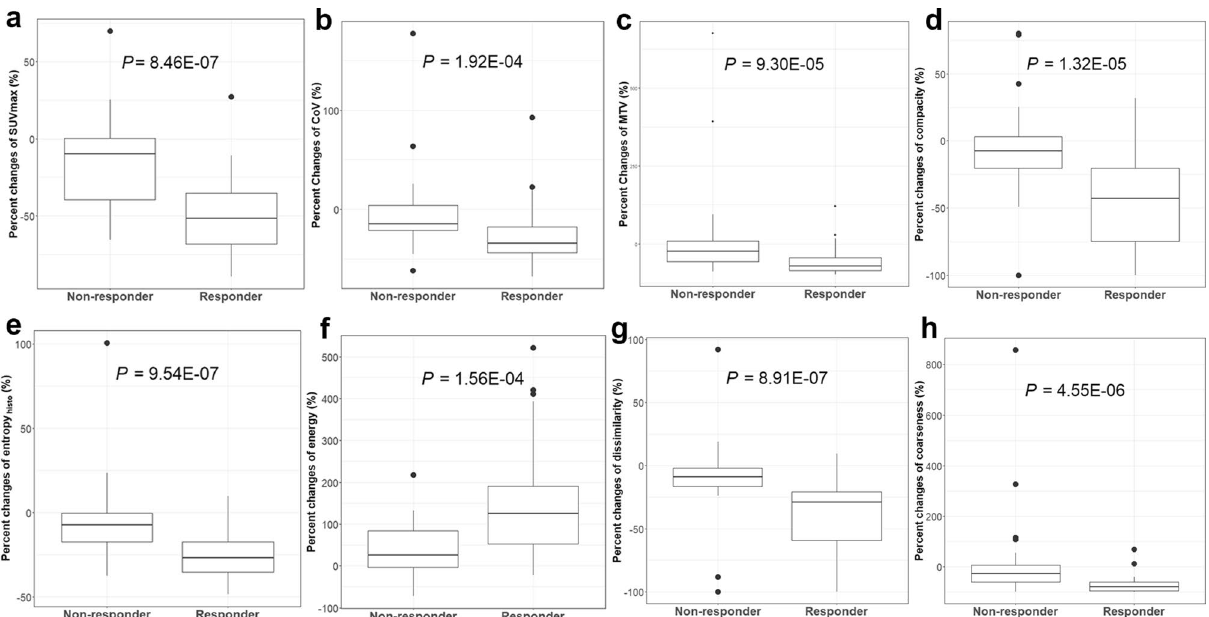
Figure 2. The percentage of changes in metabolic parameters that relate to best responses: SUV max ( a ), CoV ( b ), MTV ( c ), compacity ( d ), entropy Histo ( e ), energy ( f ), dissimilarity ( g ), and coarseness ( h ). CoV coefficient of variance, Histo histogram, SUV standardized uptake value, MTV metabolic tumor (Fig. 2). Contrast NGLDM has increased more than fivefold for non-responders, suggesting a significant increase in metabolic ITH for non-responders compared to responders. Progression‑free survival and overall survival as predicted by pathoclinical, metabolic and radiomic parameters. The univariate Cox regression analysis of pathoclinical variables for PFS and OS was described at Supplementary Table S3. ECOG, CEA, best response and best response at TP2 were associated with poor PFS, while pathology, ECOG, best response and best response at TP2 were correlated with poor OS. Especially, patients who achieved partial response showed prolonged PFS and OS compared to those with stable disease or progressive disease (Supplementary Fig. S2). The optimal cut-off values and corresponding AUC values for PFS and OS of metabolic and radiomic parameters were shown at Supplementary Table S4. Metabolic and radiomic parameters were divided into groups of high and low values according to their optimal cut-off values and then the continuous variables were transformed into binary variables. Supplementary Table S5 shows multiple significant metabolic and radiomic parameters at TP1, TP2 and delta by the univariate Cox regression analysis. Although only one metabolic variable, SUV peak , were significant at TP1 for PFS, all metabolic variables of TP2 and delta for PFS and OS were statistically significant. In addition, a number of radiomics variables were also significant at TP2 and delta for PFS and OS, compared to only a few significant ones at TP1. A correlation matrix map was used to diagnose collinearity of metabolic and radiomic parameters, and variables with r values of 0.8 or higher were excluded (Supplementary Fig. S1). Finally, the following variables remained and were used for analysis: SUV max , CoV, MTV, kurtosis, energy, contrast GLCM , correlation, entropy GLCM , contrast NGLDM , and busyness. The predictability of radiomic parameters in TP1, TP2, delta and combined variables was evaluated using C-index, and TP2 + delta model showed the best performance (Supplementary Table S6). In addition, it was confirmed that the predictive ability was improved when the pathoclinical parameters were included in